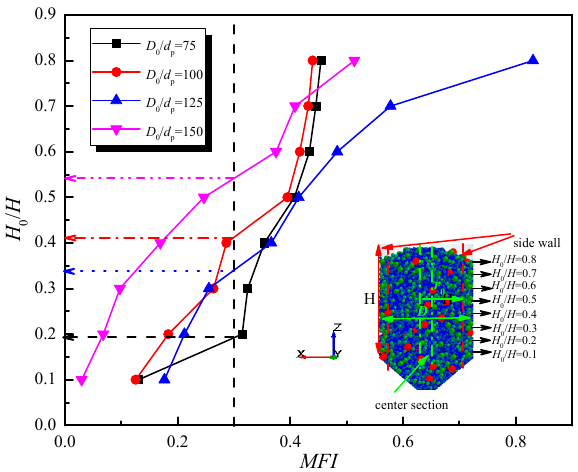
Figure 25. The variation in MFI of sinter layers with variations in the geometry factor.